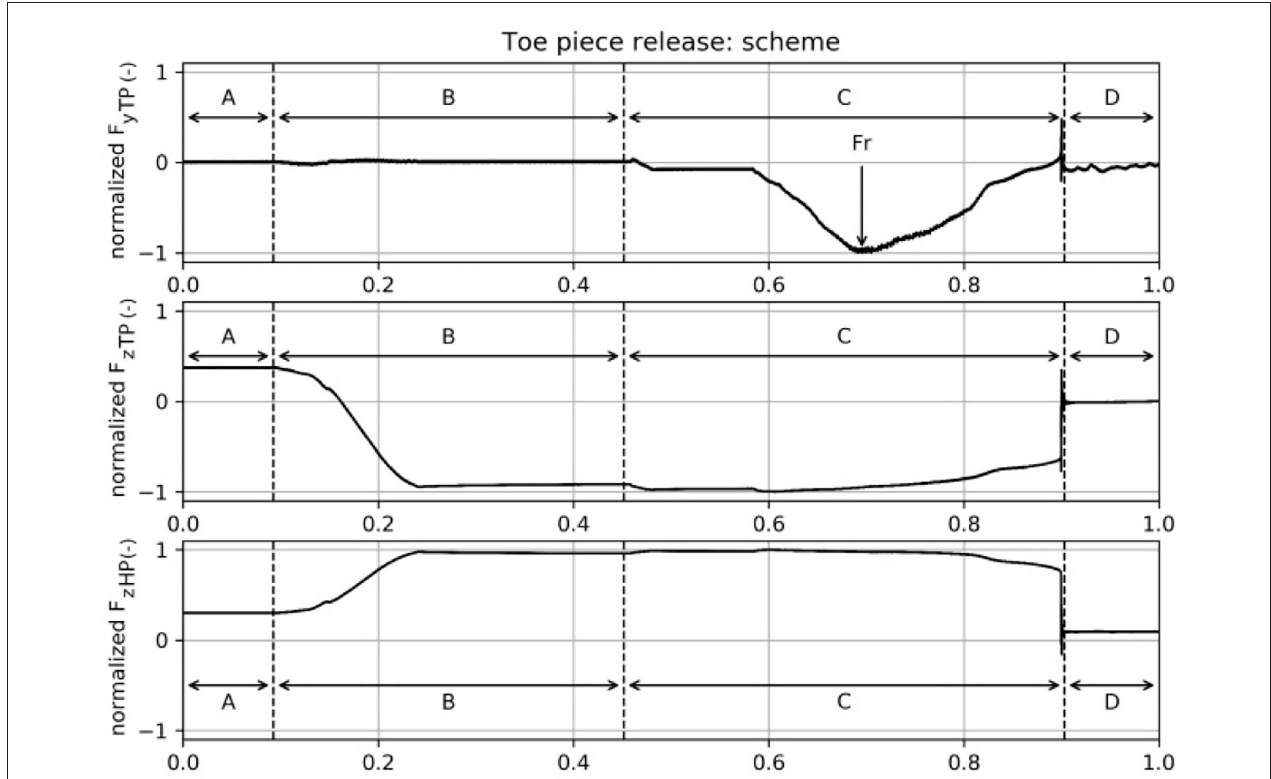
FIGURE 5 | Toe piece release motion scheme, time signals: A—boot rests in binding, B—center of mass moves backwards, C—lateral movement of the boot tip, D—boot released ( F r ... release